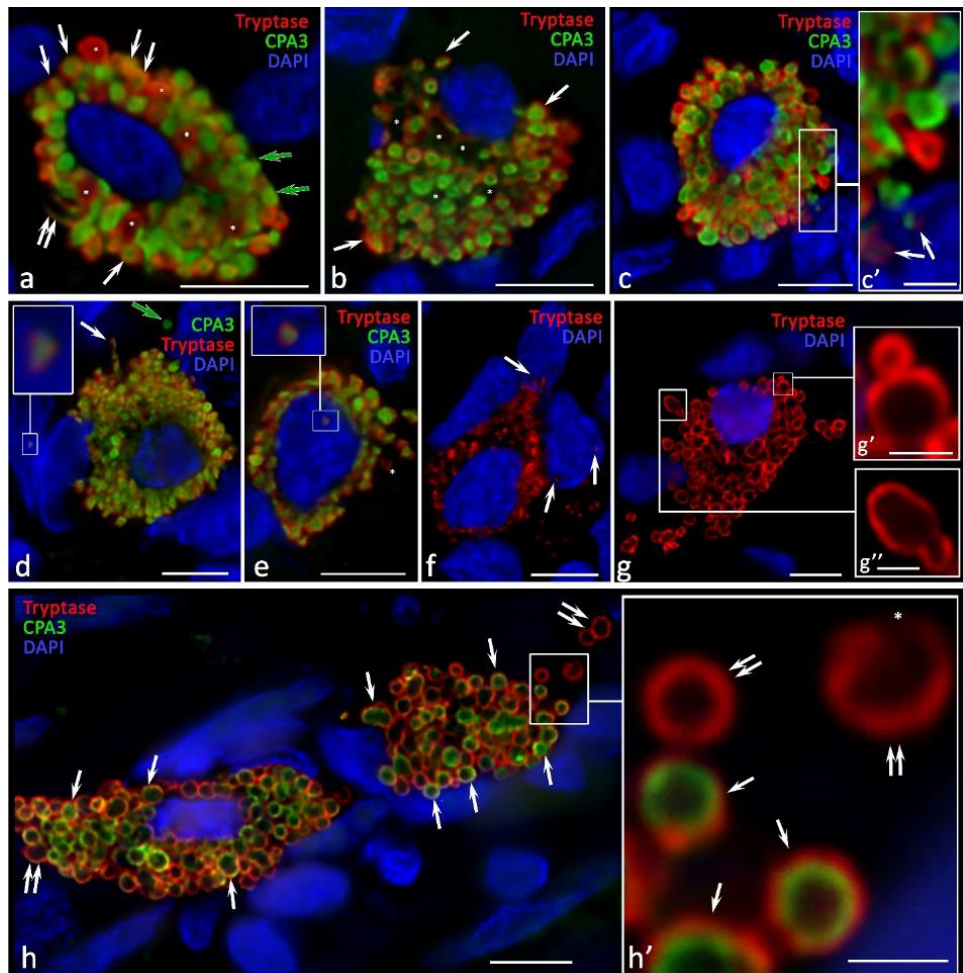
Figure 5. Cytotopography of specific proteases of ovarian mast cells with endometriomas. ( a ) MCs with a centrally located nucleus and large secretory granules with phenotypes Tr + CPA3 − (indicated by an asterisk), Tr − CPA3 + (indicated by a green arrow), and Tr + CPA3 + (indicated by an arrow). Thin cytoplasmic outgrowths immunopositive for tryptase and CPA3 are visible (indicated by a double arrow). ( b ) MCs with an eccentrically localized nucleus and a large number of secretory granules, with a predominant content of both specific proteases (indicated by an arrow). In the cytoplasm, there are areas that are not filled with specific proteases (indicated by an asterisk. ( c ) The secretion of tryptase and CPA3 is accompanied by transport to the nucleus of the neighboring cell (indicated by the arrow in ( c (cid:48) ); ( c (cid:48) ) is an enlarged fragment of ( c )). ( d ) MCs with secretory granules of predominantly medium size, the cytoplasmic outgrowth is clearly visible in the direction of the neighboring cell (indicated by an arrow). A loose-lying granule in the intercellular matrix with the Tr − CPA3 + phenotype is visible (indicated by a green arrow). An enlarged fragment shows tryptase and CPA3 in the nucleus of a stromal cell. ( e ) MCs with a small number of secretory granules containing both specific proteases. An enlarged fragment shows tryptase and CPA3 as part of a granule in the MC nucleus. ( f ) MCs with small tryptase-positive formations in the cytoplasm, entering the extracellular matrix and penetrating the nuclei of other cells. ( g ) Tryptase-positive MCs with a clear localization of the protease in the peripheral region of the secretory granules. The mechanisms of secretory granules association ( g (cid:48) , g (cid:48)(cid:48) ) are clearly visible. ( h ) A large MC filled with granules (on the left) and a nuclear-free fragment filled with secretory granules, with a predominant Tr + CPA3 + phenotype (indicated by an arrow). Of a smaller number are granules that do not contain CPA3 (indicated by a double arrow). ( h (cid:48) ) is an enlarged fragment of ( h ) showing the release of the secretome from the granule (indicated by an asterisk). Scale: ( c (cid:48) , g (cid:48) , g (cid:48)(cid:48) , h (cid:48) ) 1 µ m, the rest—5 µ